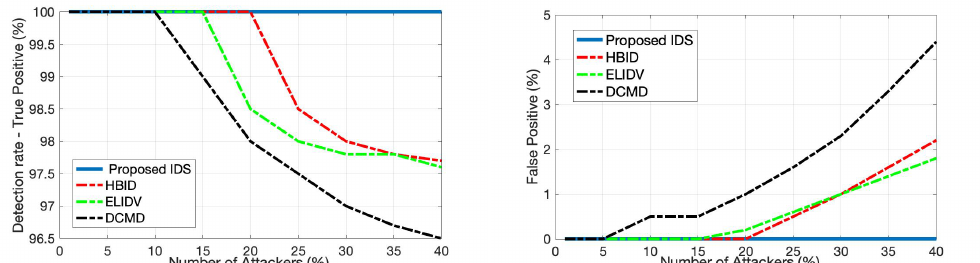
Figure 7. Comparison considering FDI attack in speed values between the proposed detector and several voting-based detectors from the